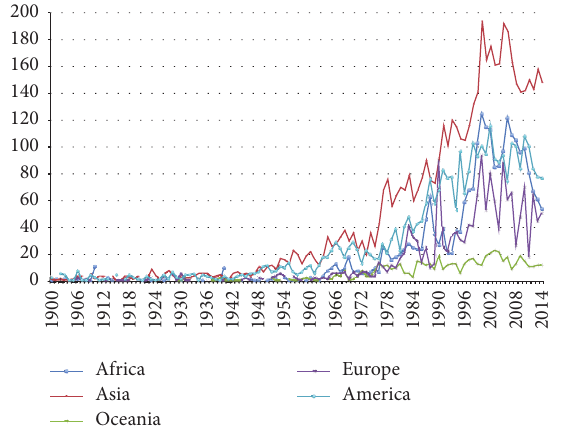
Figure 1: Number of natural disasters in the world from 1900 to 2014.